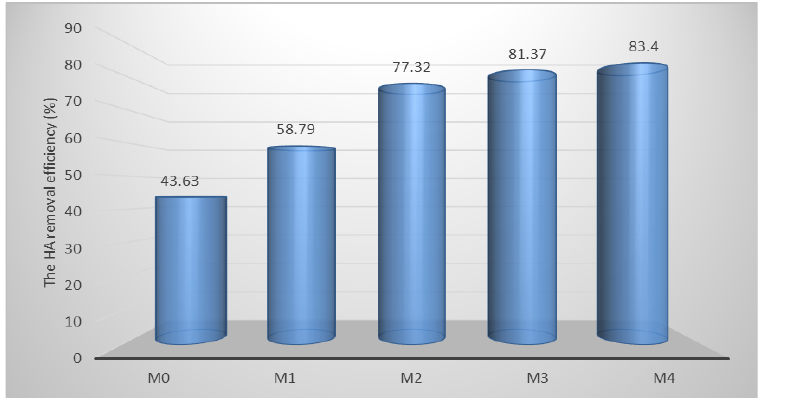
Figure 9. Percentage of HA removal using the synthesized membranes containing different amounts of the ZnO nanoparticle (initial HA concentration=2 mg/L, pressure=5 bar, temperature=25±3°C and time=30 min).